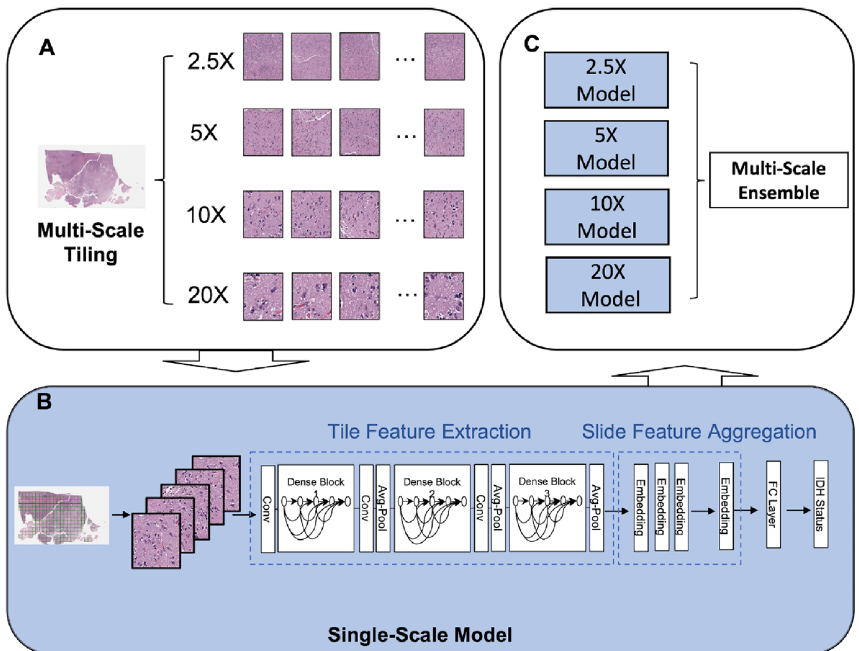
Figure 1. A schematic for the end-to-end process of model training and deployment. WSI are tiled into patches of 256 × 256 size at 2.5×, 5×, 10×, and 20× magnification factors (1 A ). In each training iteration (mini- batch), 200 randomly selected and augmented patches from a single magnification of a single WSI were passed to single-scale Densenet121 classifiers, initialized with imageNet pre-trained weights. Feature embedding vectors from each patch were then aggregated using naïve averaging, and the resulting vector was then passed to a final fully connected (linear) classifier (1 B ). Following training, the predictions three versions of each single-scale model trained with different random seeds were averaged to produce a single-scale ensemble, and the predictions from each single-scale ensemble were averaged to produce the multiscale ensemble (MSE) predictions (1 C